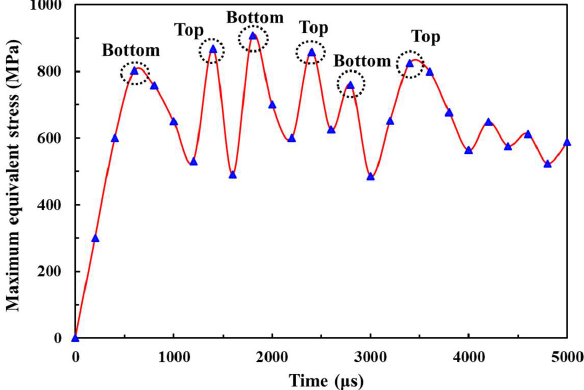
Figure 12. Maximum equivalent stress time-varying curve.